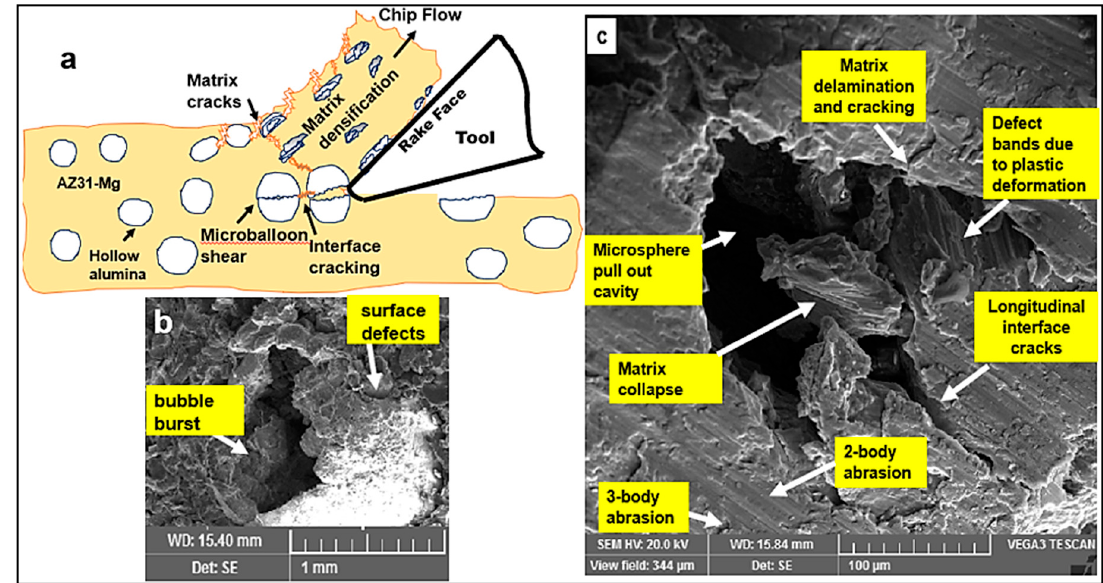
Figure 6. Ceramic microballoon failure mechanisms constituting shear failure during cutting AZ31 metal syntactic foams. ( a ) representative chip formation ( b ) fractured bubble ( c ) key deformation mechanisms